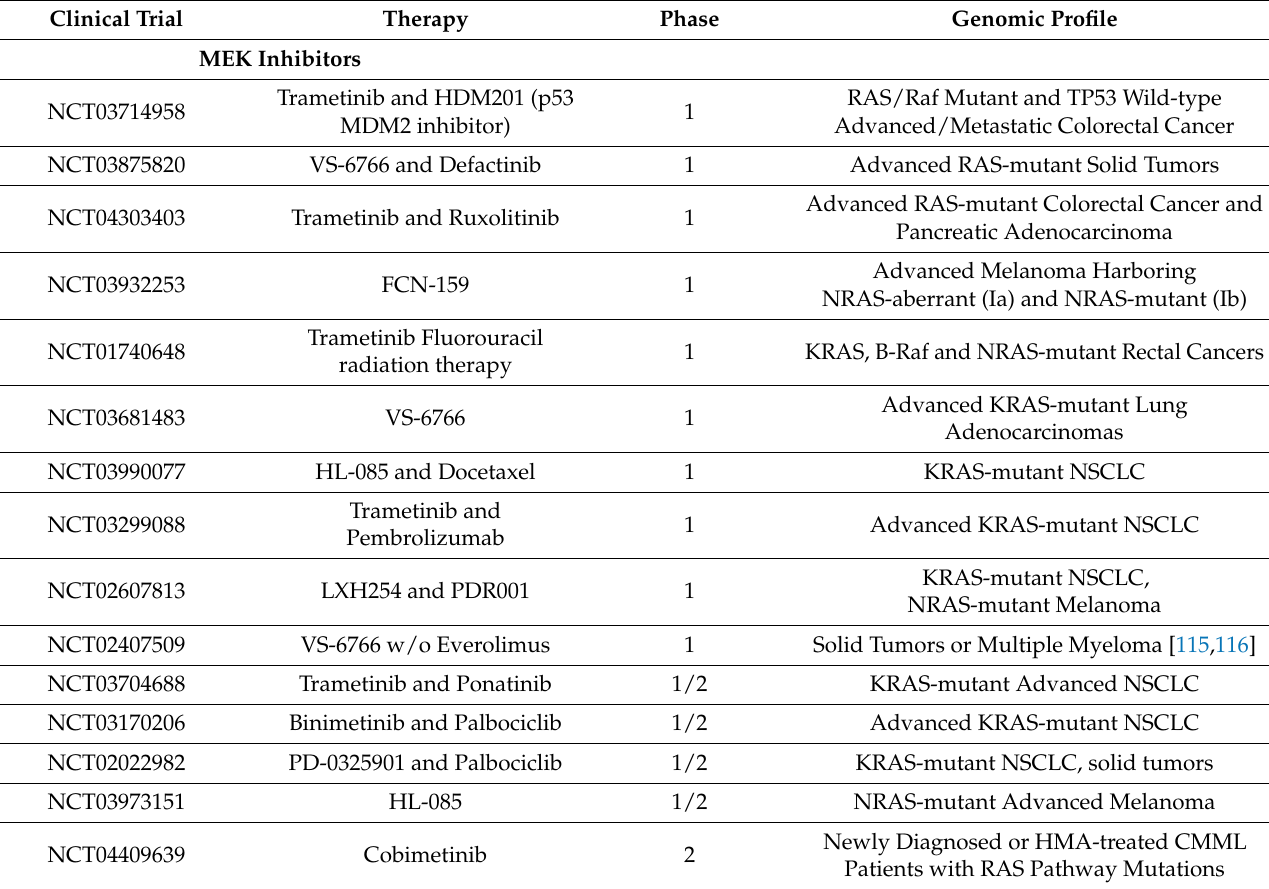
Table 2. Active or recruiting clinical trials for the treatment of RAS mutant